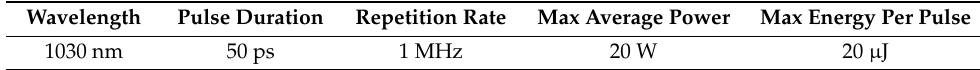
Figure 2. Laser processing experimental configuration for silicon engraving and drilling. The following acronyms are used, HWP: Half-wave plate, PBS: Polarizing beamsplitter cube. Table 1. Laser characteristics.